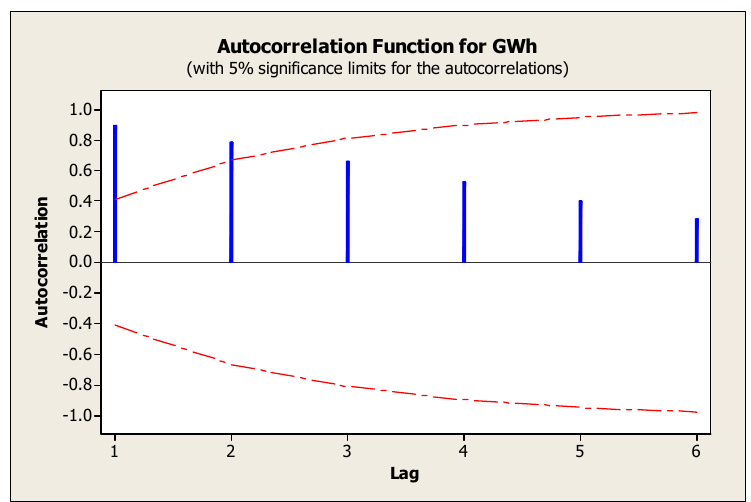
Figure 2. Correlogram of electricity